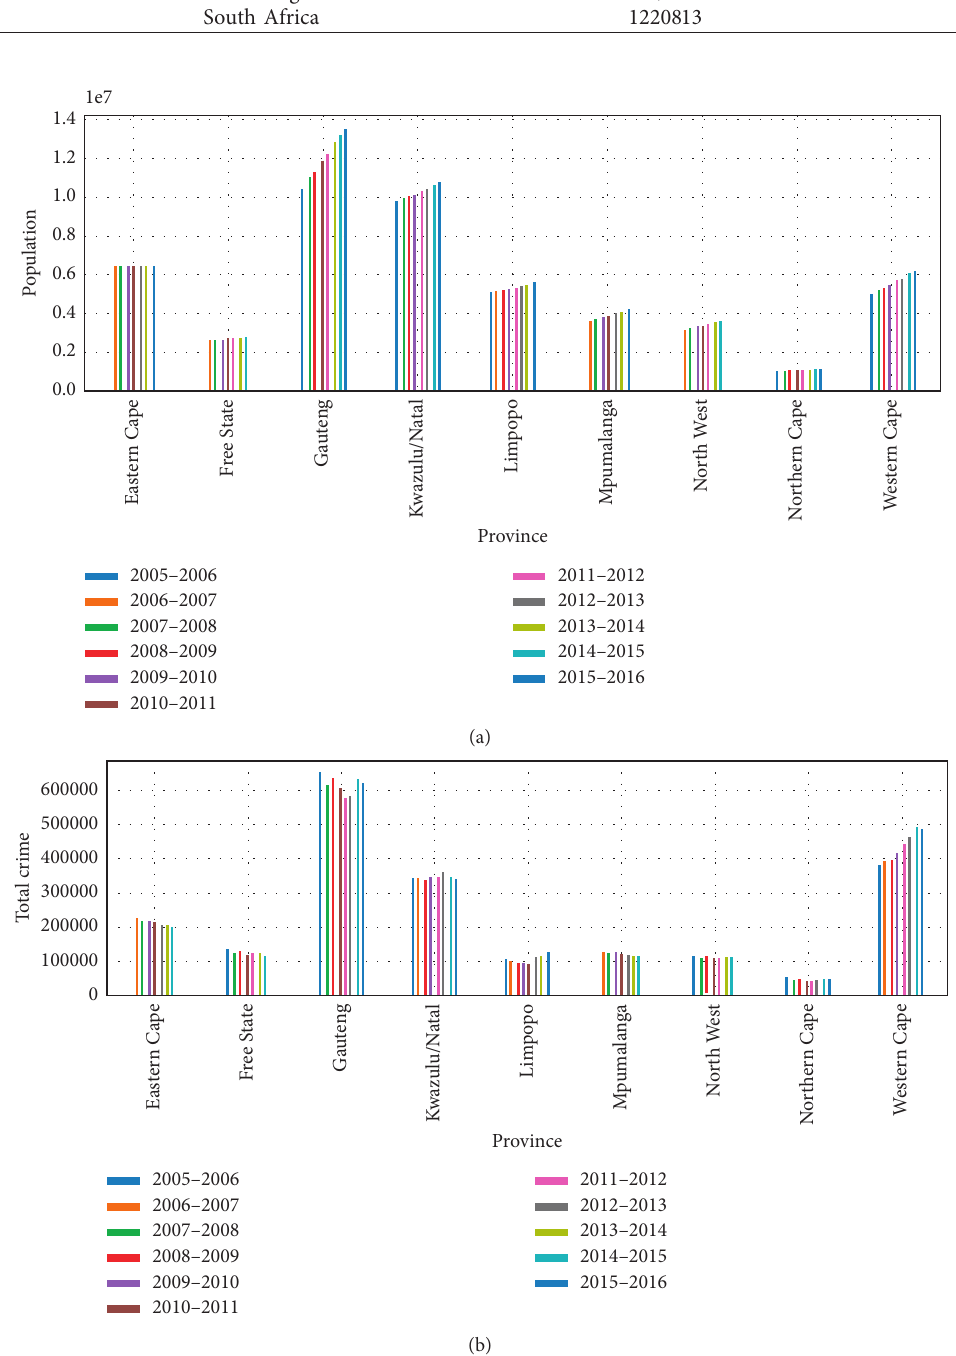
Figure 2: 2005–2016 South Africa population and crime statistics. (a) Population statistic. (b) Crime